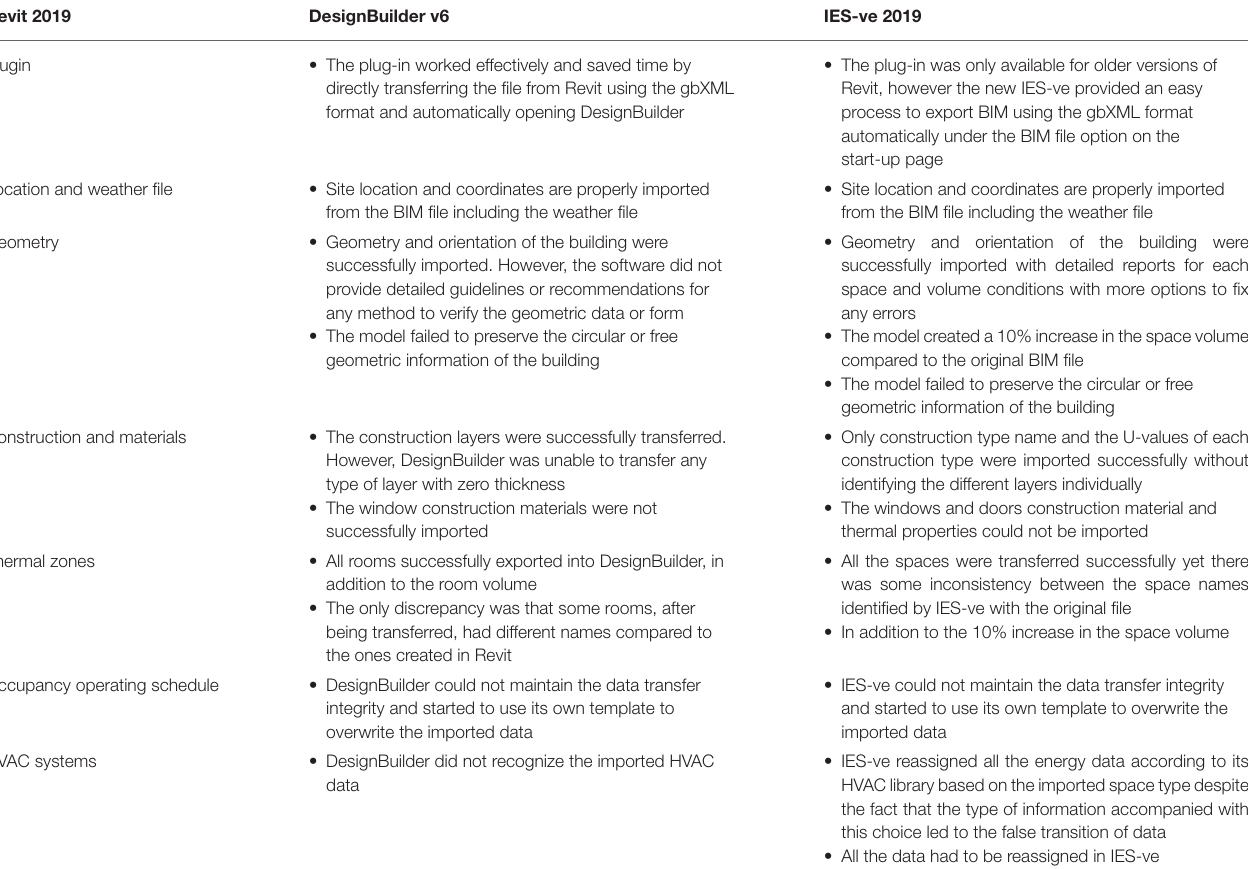
TABLE 5 | Summary of overall interoperability issues between Revit and BEM